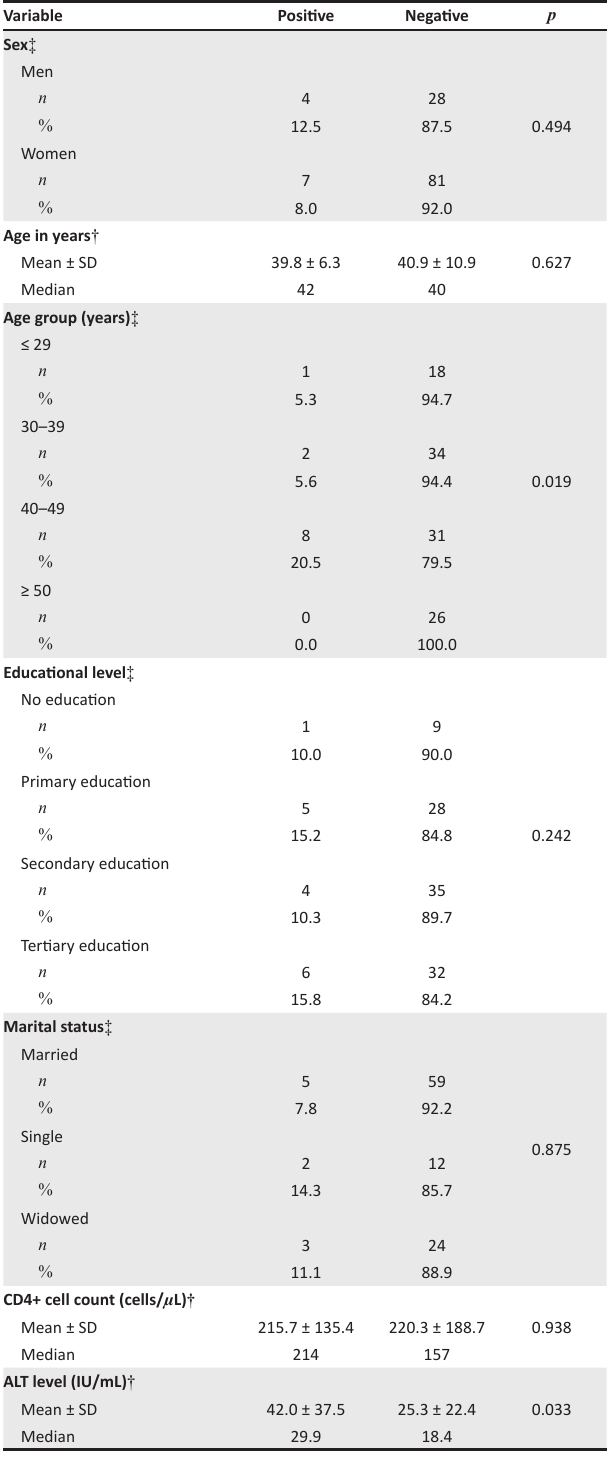
TABLE 3: Socio-demographic characteristics and laboratory parameters of HBV infection among HIV-positive adult patients, Jos University Teaching Hospital HIV clinic, August